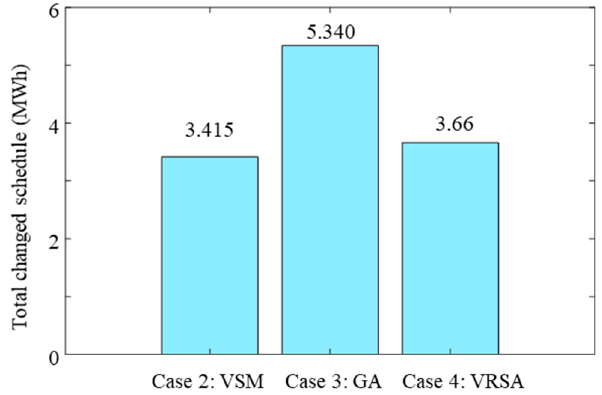
Figure 11. The total changed CL schedule.